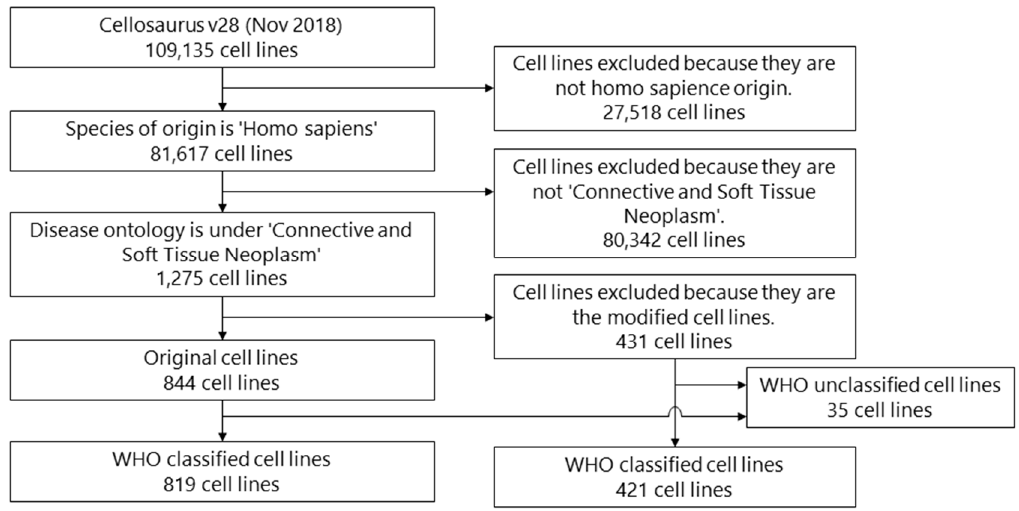
Figure 1. Flow diagram of the systematic review process.